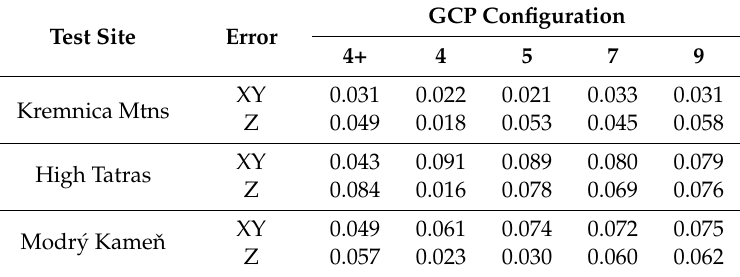
Table 5. Root mean square horizontal and vertical residuals at the ground control points after transformation.